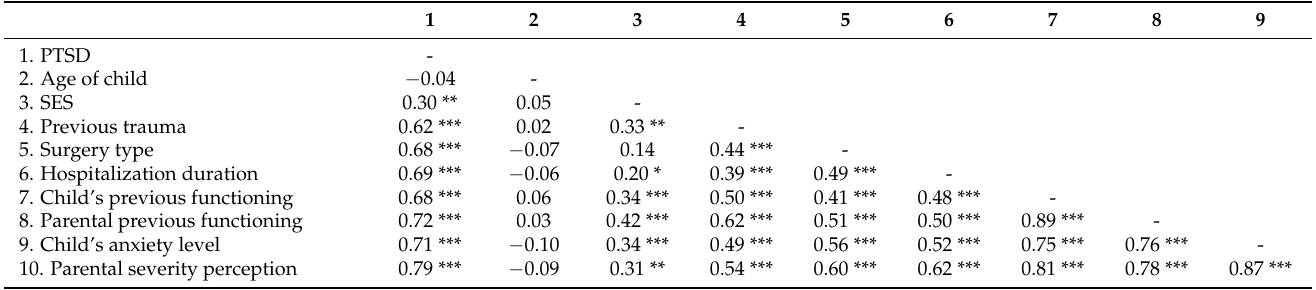
Table 2. Correlations between PTSD and background and screening variables—Arabs ( n = 102). Table 3. Correlations between PTSD and background and screening variables—Jews ( n = 151).